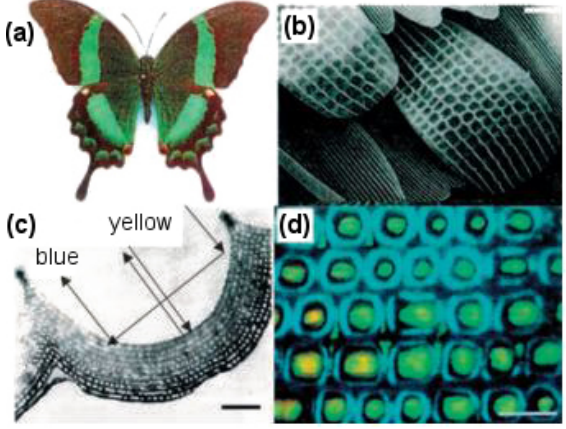
Figure 15. Color-mixing phenomenon displayed by Papilio palinurus butterfly wings resulting from the concavities across the surface of the wing scales. ( a ) P. palinurus butterfly with a wingspan of 100 mm; ( b ) Scanning electron microscopy (SEM) image showing the overlapping roof tile pattern of scales on the butterfly wing surface; ( c ) Transmission electron microscopy (TEM) image showing a cross section through one concavity on a P. palinurus butterfly scale and color-mixing mechanism; ( d ) Optical micrograph showing repeated structures of lamellae and reticulum forming arrays to display colors [72]. Scale bars: ( b ) 5 µ m, ( c ) 1 µ m, and ( d ) 10 µ